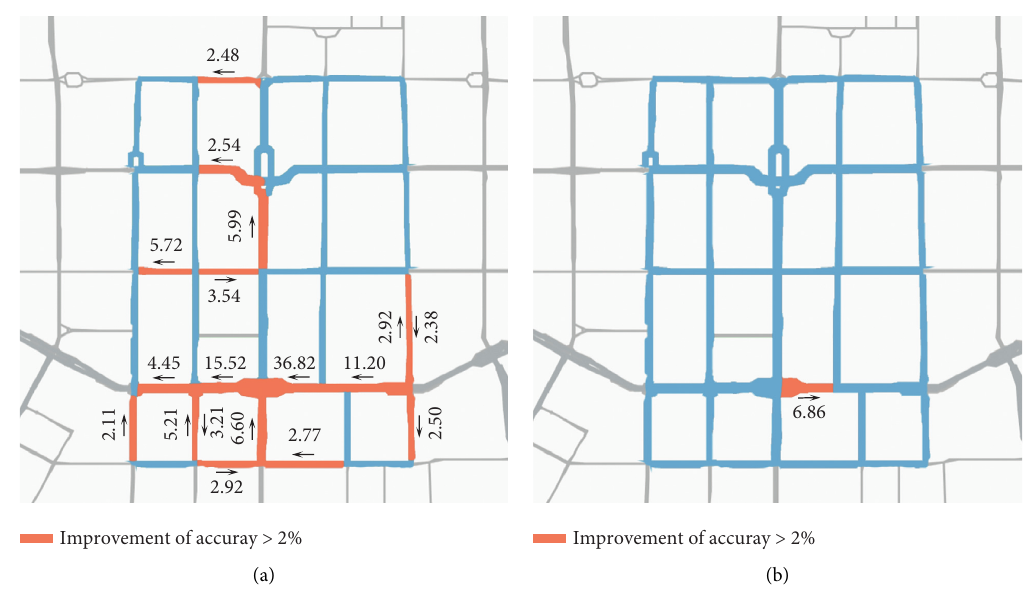
Figure 8: Accuracy improvement by progressively increasing the number of critical segments.